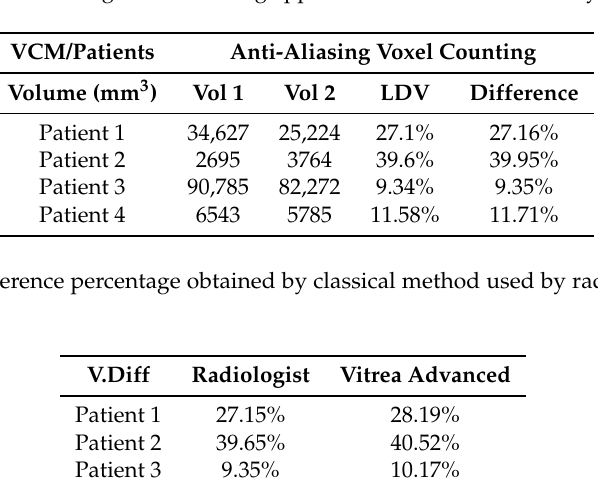
Table 2. Anti-aliasing voxel counting applied on the local dissimilarity volume.